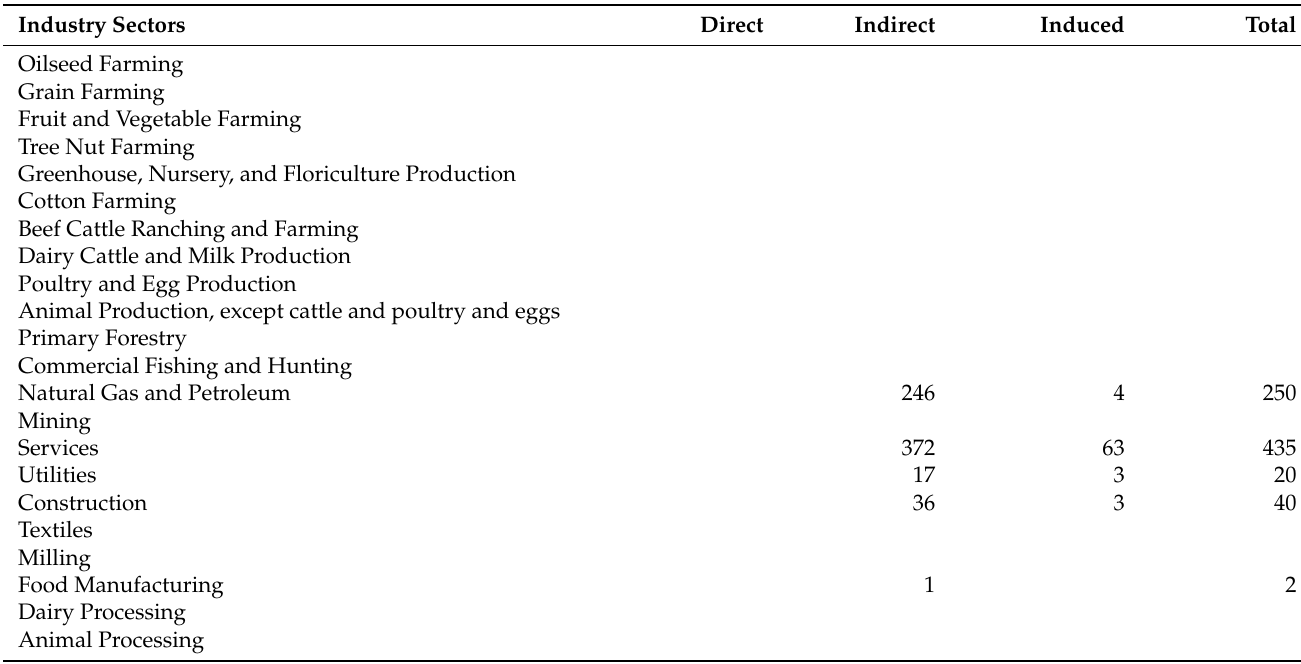
Table 7. Contribution of the water transportation to value-added by industry ($